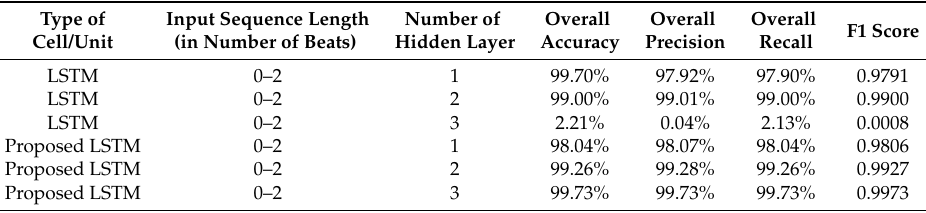
Table 7. Performance summary of the proposed bidirectional LSTM in MITDB analysis 2 of Figure 9b.